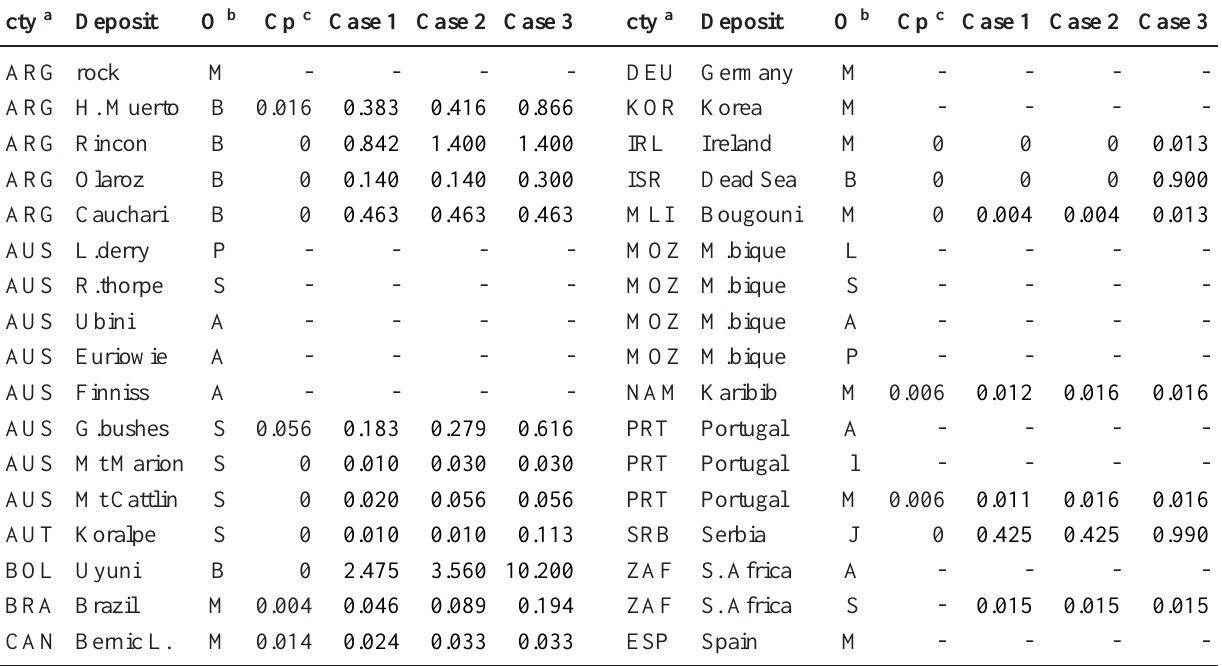
Table 4. Lithium assumed ultimately recoverable resources (Mt